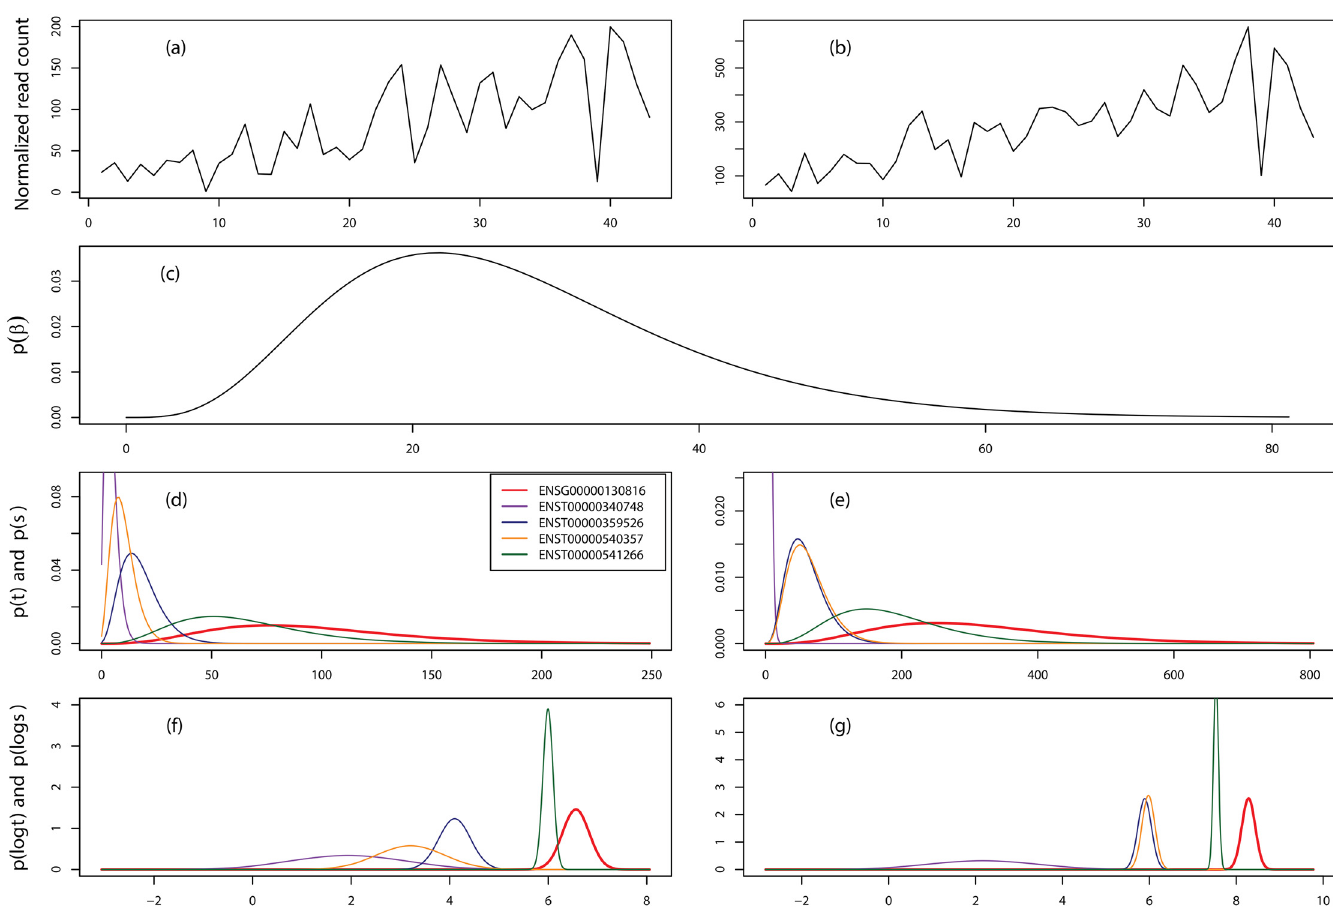
Fig 3. Transcript expression deconvolution by PGseq for gene ENSG00000130816. (a) and (b) show the normalized read counts for samples HBR and UHR, respectively, for each exon. (c) shows the estimated gene-specific read distribution. The 3rd panel shows the obtained NB distributions for both gene and isoforms for the two samples. The last panel presents the approximated Gaussian distributions of logged gene and isoform expression. This gene contains four isoforms and the total normalized read counts for both samples are 601 and 2341, respectively.